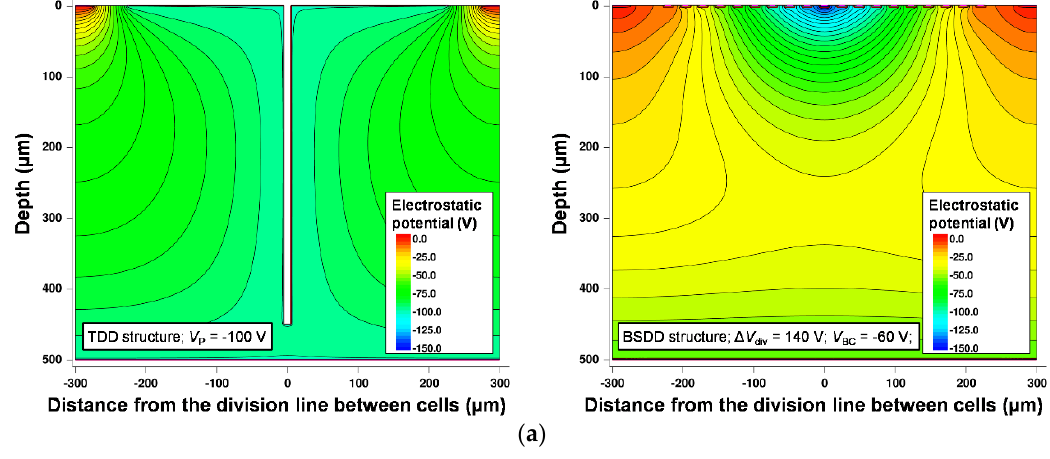
Figure 12. Cont. Figure 12. Cont